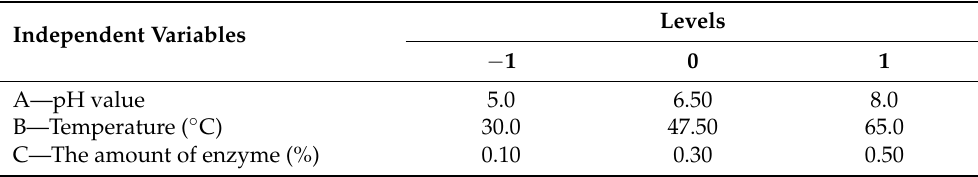
Table 1. Three independent variables with their corresponding